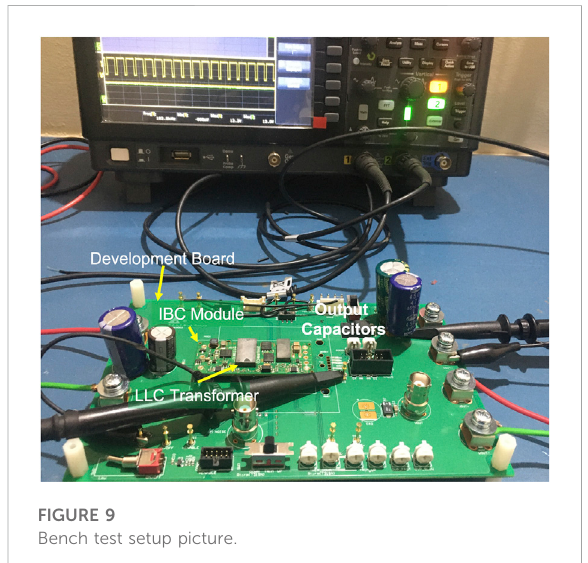
FIGURE 9 Bench test setup picture.